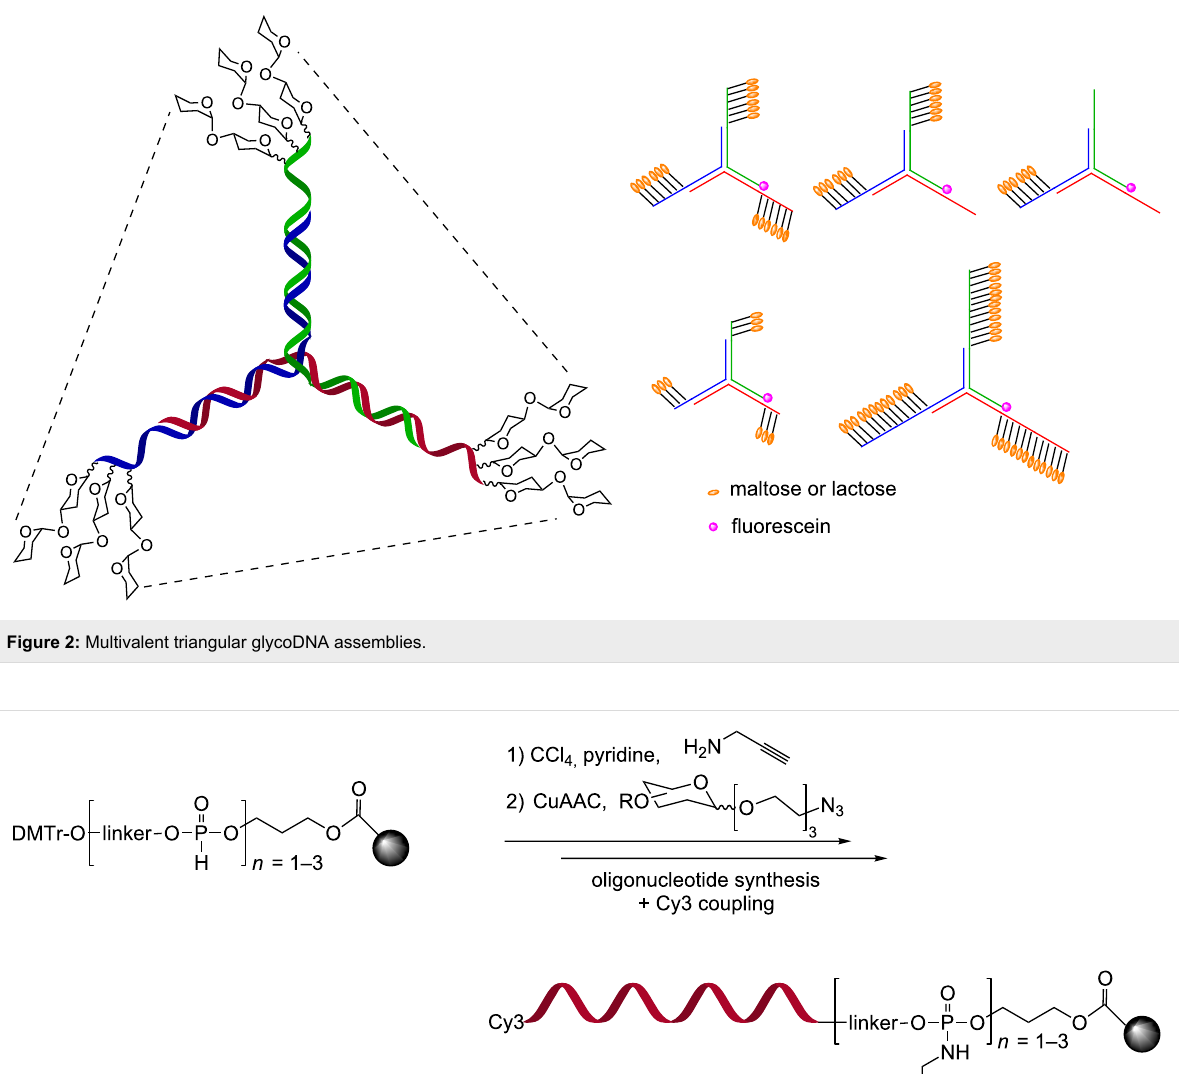
Scheme 4: Preparation of the DNA glycoconjugate by CuAAC.